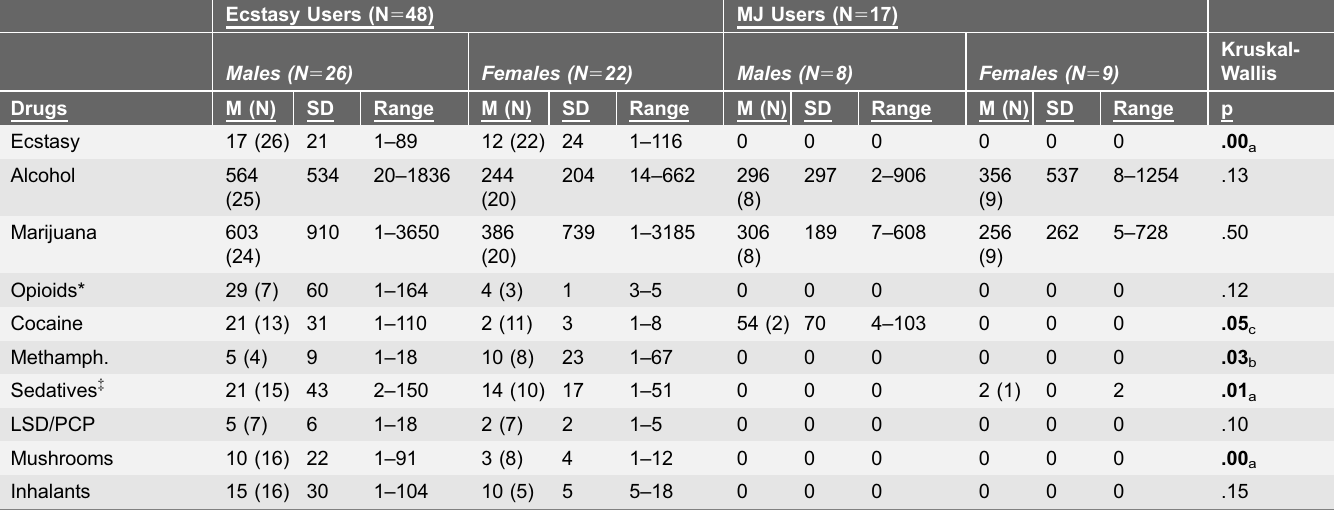
Table 2. Past Year Quantity of Drug Use (in Standard Units) According to Group and